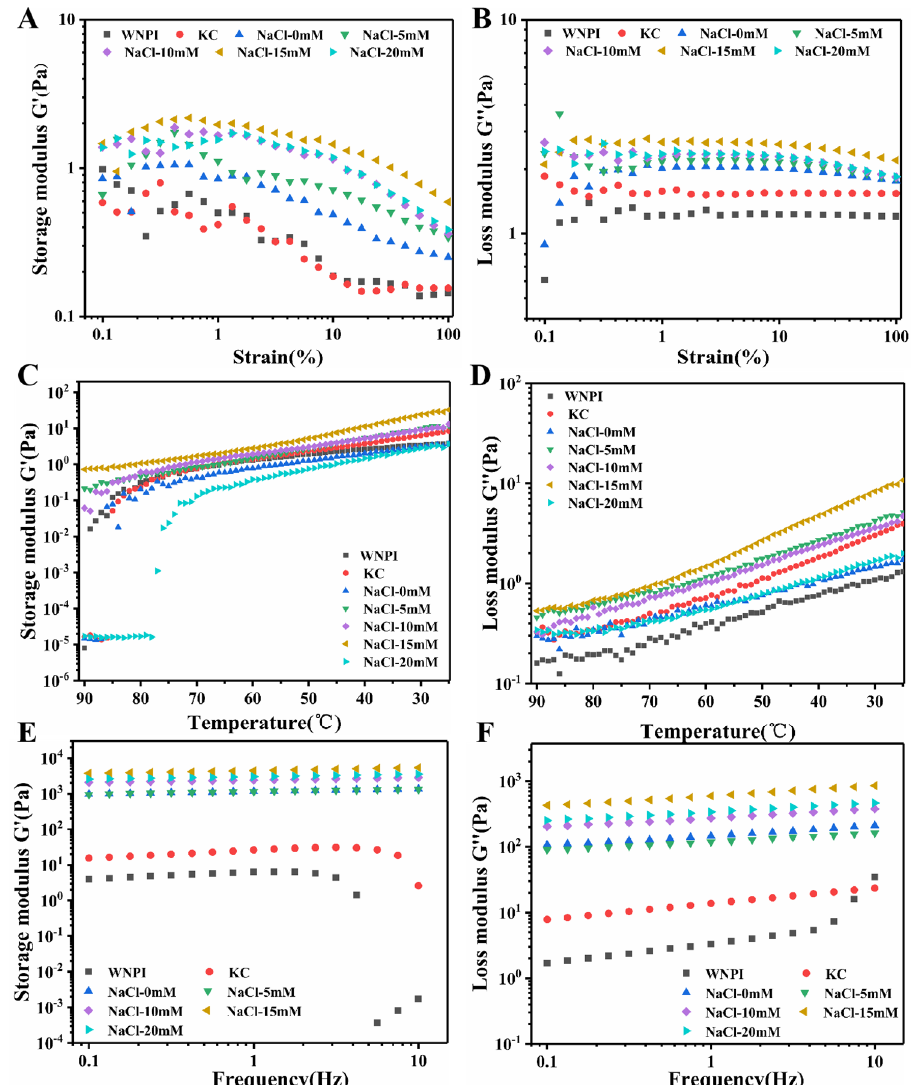
Figure 1. Rheological behaviors of WNPI-KC composite gel samples with NaCl. ( A ) and ( B ): Storage modulus (G′) and loss modulus (G″) of composite gel samples with NaCl during strain sweep; ( C ) and ( D ): G′ and G″ of the composite gel samples with NaCl during cooling process; ( E ) and ( F ): G′ and G″ of the composite gel samples with NaCl during frequency sweep.